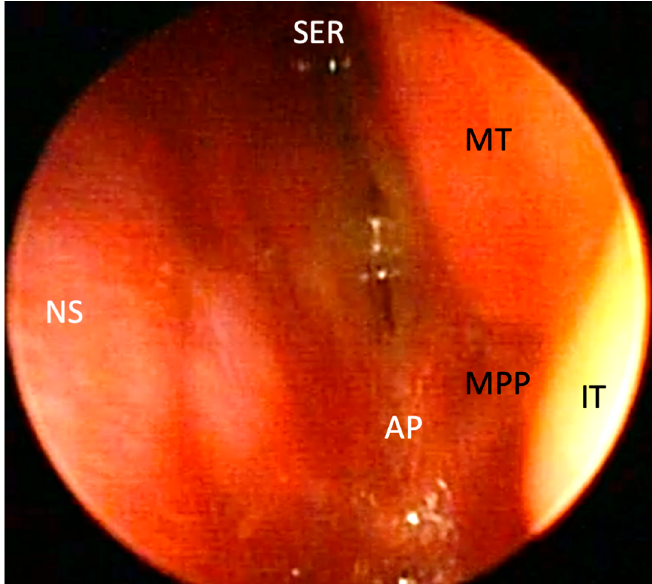
Figure 2. Endoscopic photograph of the left nasal cavity in a three-day-old neonate with bilateral bony choanal atresia. SER—sphenoethmoid recess; NP—nasal septum; MT—middle turbinate; IT— inferior turbinate; MPP—medial pterygoid plate; AP—atretic